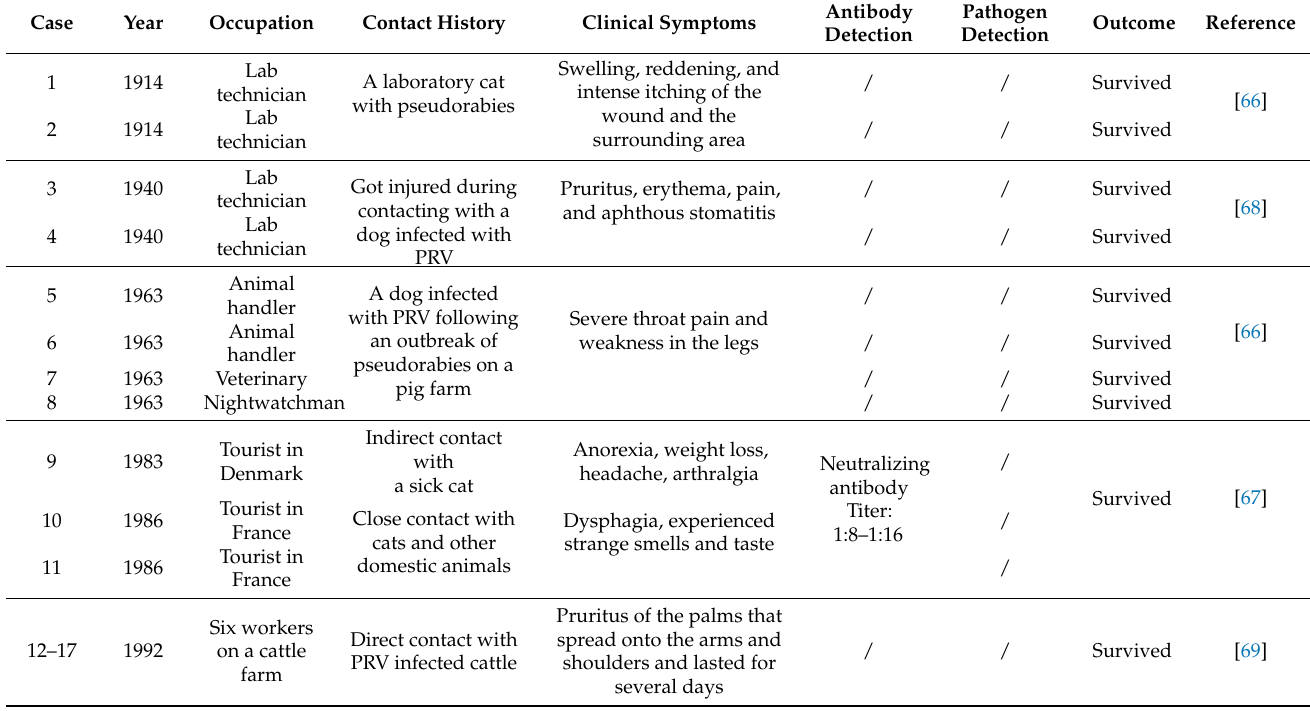
Table 3. Suspected case reports of human infection with PRV between 1914 and